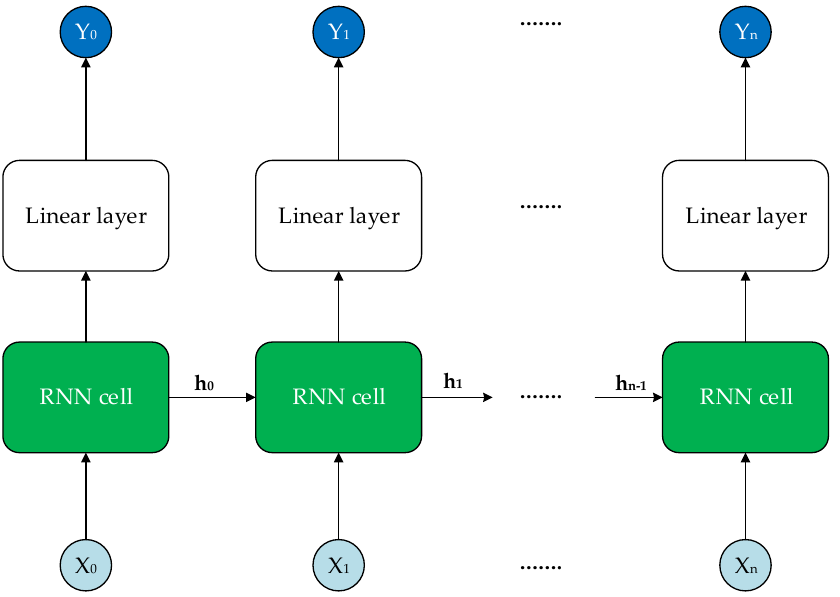
Figure 7. The illustration of the proposed RNN